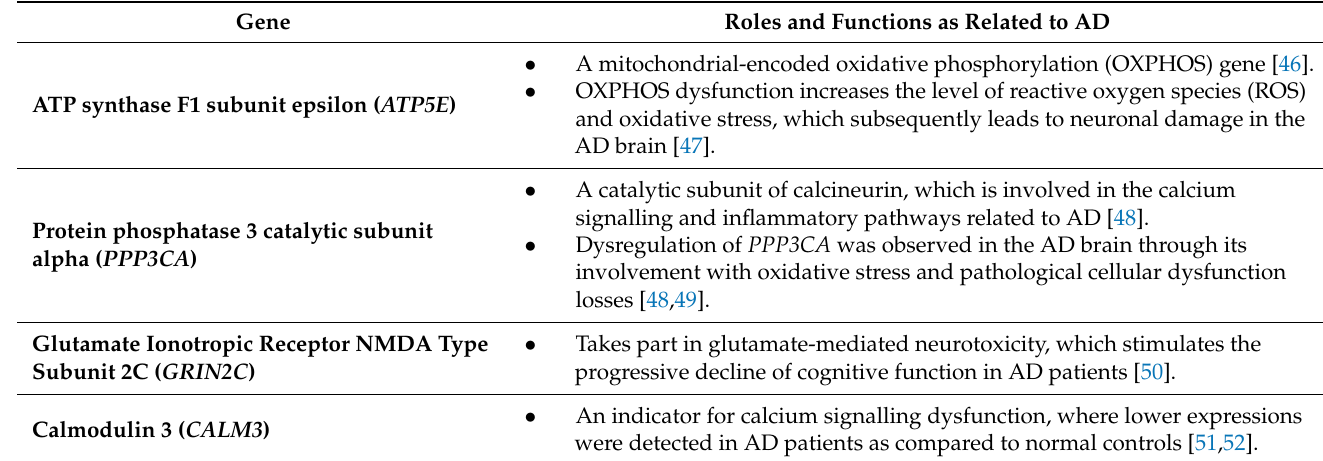
Table 5. List of target genes and their roles and functions as related to AD. Gene Roles and Functions as Related to